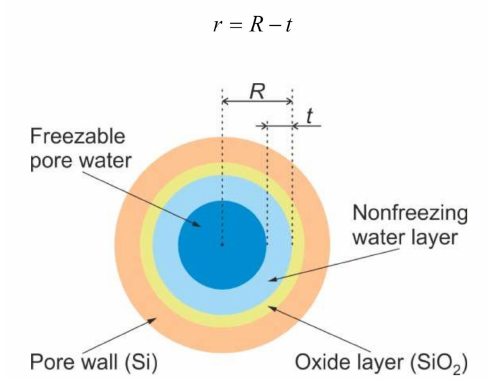
Figure 5. Model of water states in cylindrical mesopore of nanostructured